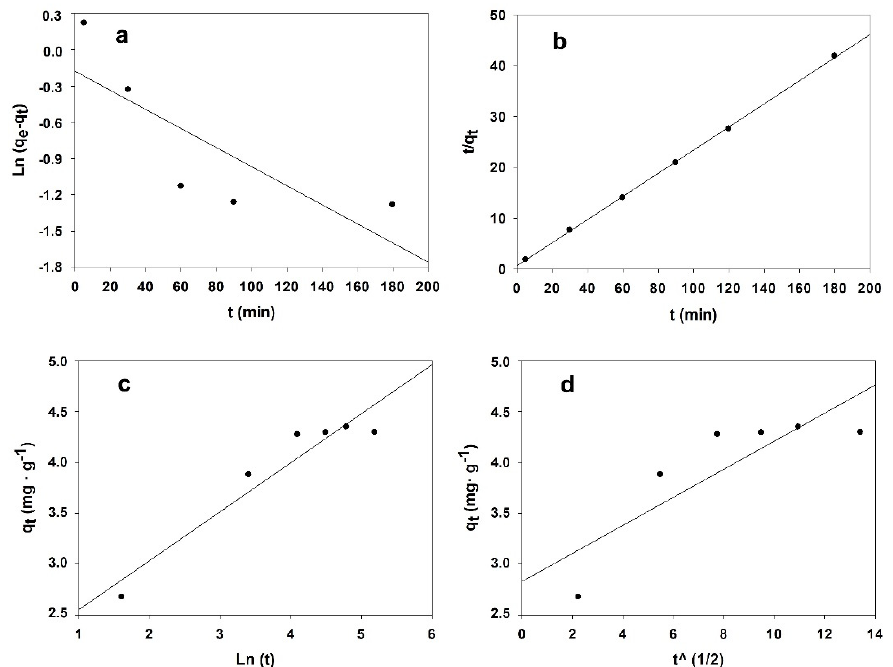
Figure 3. Kinetic models for 20 ppm concentration: ( a ) pseudo-first order kinetic model; ( b ) pseudo- second order kinetic model; ( c ) Elovich kinetic model; ( d ) and interparticle diffusion kinetic